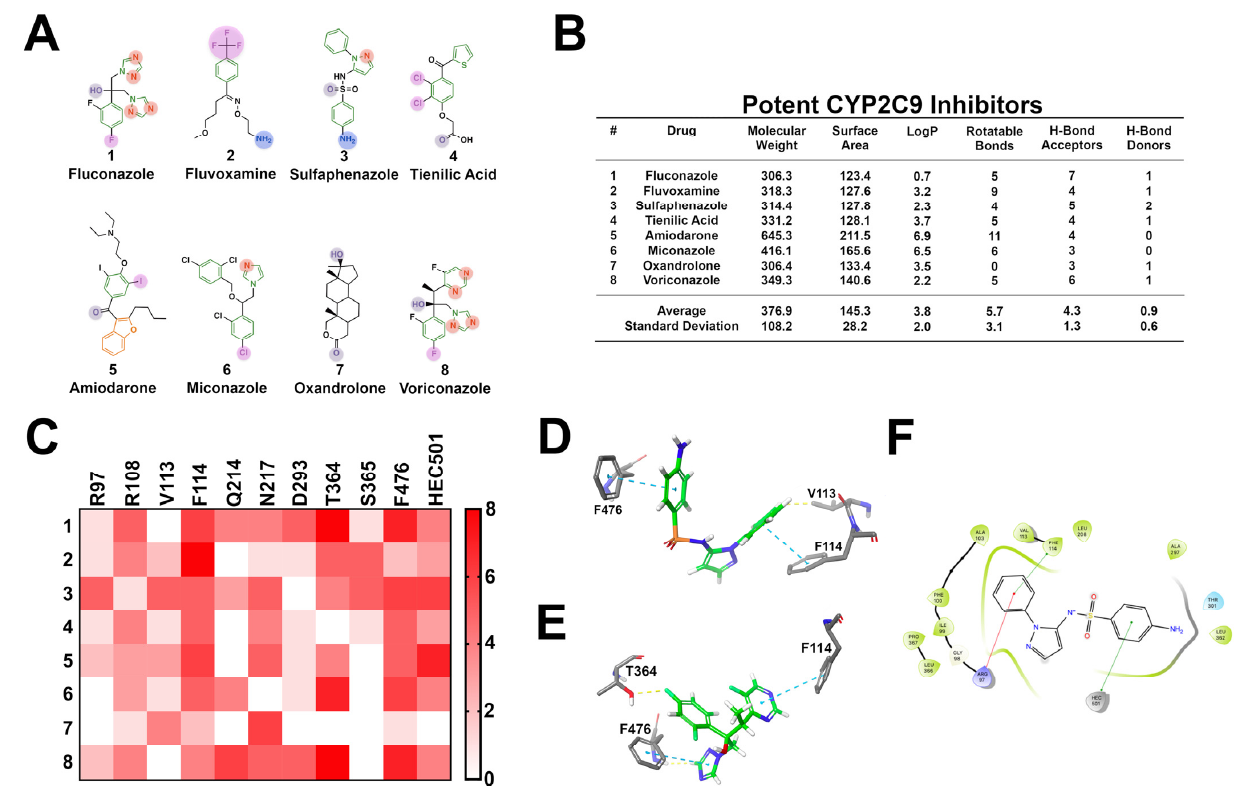
Figure 7. Structural investigation of 8 well-known high-affinity CYP2C9 inhibitors. ( A ) The common structural features seen in CYP2C9 inhibitors include aromatic rings, aromatic nitrogens, heterocycles, primary amines, and halogens. Purple moieties interact with N217; magenta interact with T364; green interact with F114, F476, and/or heme; blue interact with S365; red interact with Q214; and orange interact with heme. ( B ) Molecules tend to be moderately sized with varying lipophicity. CYP2C9 inhibitors are moderately flexible and possess numerous H-bond acceptors. ( C ) Heat map representing the frequency of ligand-to-amino acid binding interactions in the top ten most energetically favorable binding poses in docking against CYP2C9 (PDB ID: 1OG5). Ligand interactions are highly diverse, with key interactions including R108, F114, F476, and heme-501. ( D ) Three-dimensional docking image depicting sulfaphenazole forming pi–pi stacking interactions between F114 and F476, as well as energetically favorable contacts with V113. ( E ) Three-dimensional docking image portraying voriconazole interacting with F114, T364, and F476. ( F ) Two-dimensional ligand interaction map depicting sulfaphenazole interacting with R97 and F114, while coordinating with the iron of heme-501.